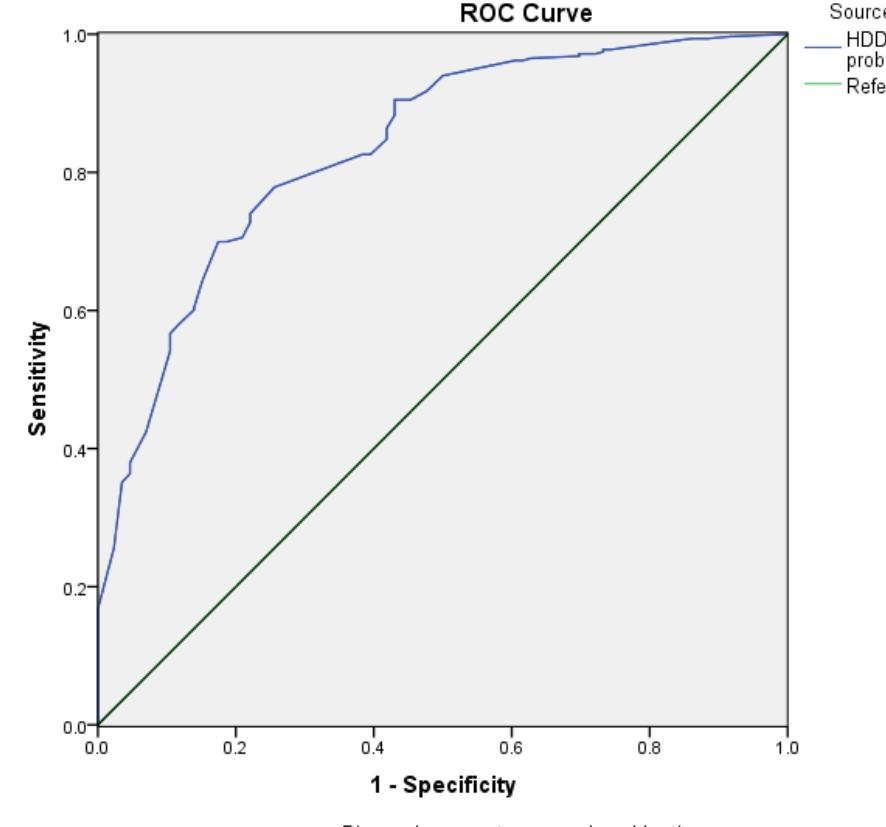
Figure 4. Receiver-operating characteristic curve for a multivariate logistic regression model to predict Khmer household dietary diversity in Tri Ton district.